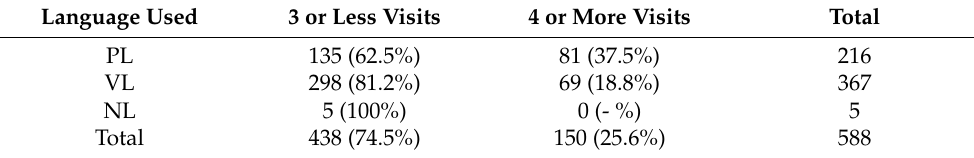
Table 3. Frequency of clinic visits by patients during the study period, by language